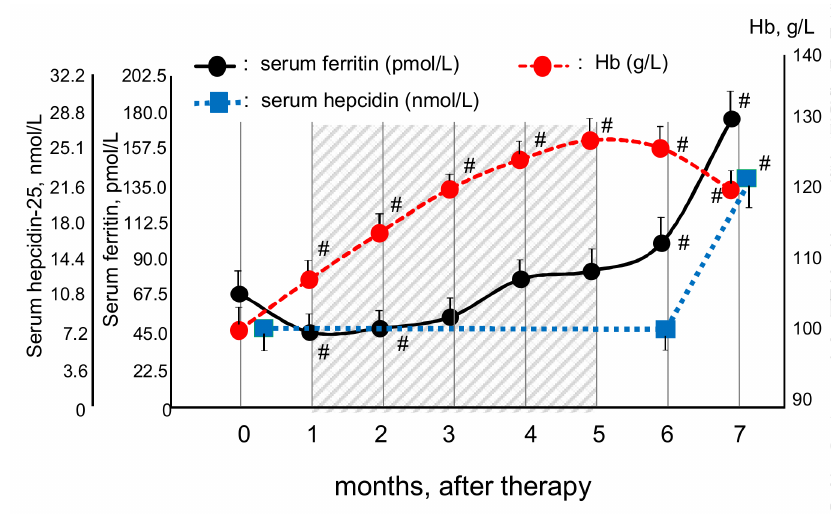
Figure 4. Sequential change in the levels of Hb, serum ferritin and hepcidin-25 in OIT-responders during OIT. The levels of Hb rose linearly with a peak at 5 months after OIT and then slightly decreased at the end of the study. Serum levels of ferritin were decreased from baseline at 1 month, and then rose continuously from 2 to 7 months after OIT. Serum levels of hepcidin-25 were similar to baseline at 6 months but significantly increased at the end of the study. Serum levels of hepcidin-25 were positively correlated with those of ferritin in the OIT-responders ( r = 0.869, p = 0.0002). Data are expressed as mean ± SEM. Comparison of 2 means was determined by the Man–Whitney U test. # p < 0.01, vs. data at 0